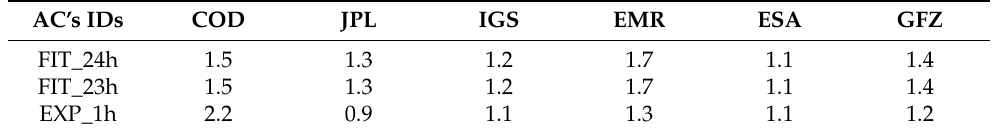
Table 1. 1D-RMS for orbit fitting and prediction (unit: